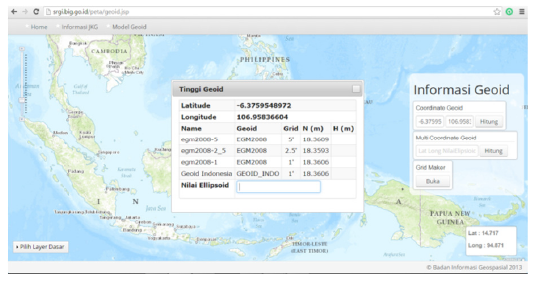
Fig 2. Calculation on SRGI website